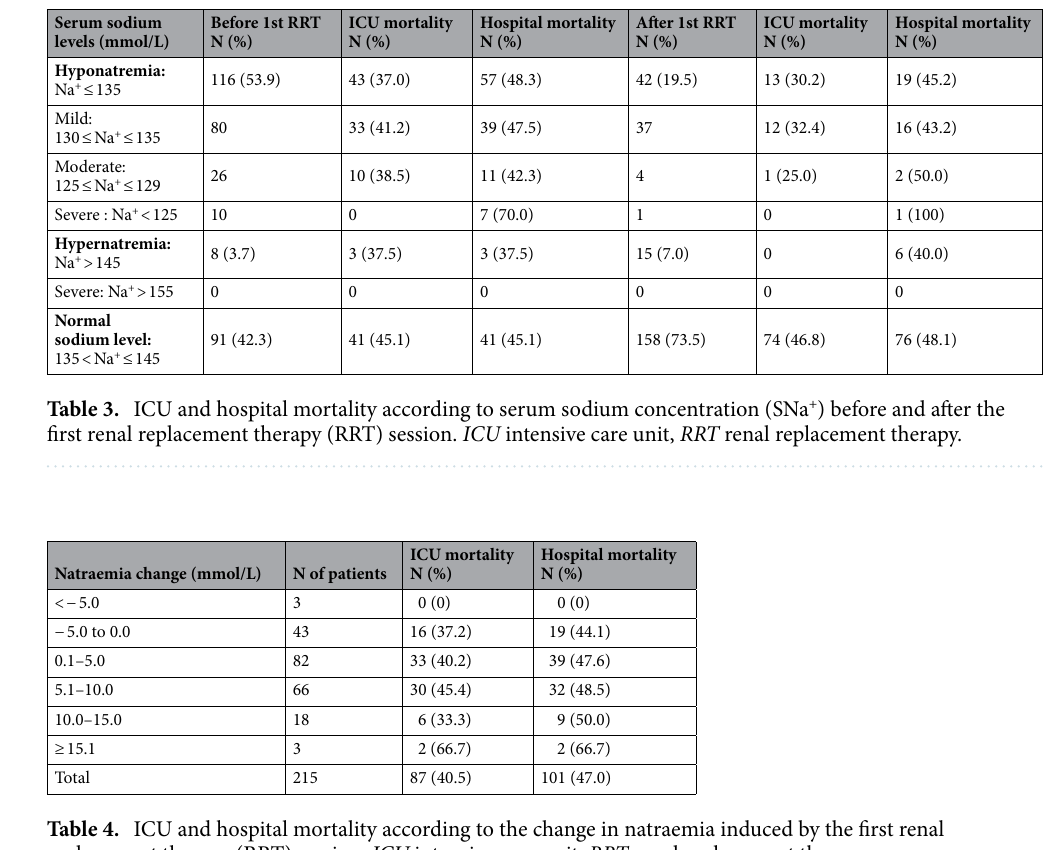
Table 4. ICU and hospital mortality according to the change in natraemia induced by the first renal replacement therapy (RRT) session. ICU intensive care unit, RRT renal replacement therapy.